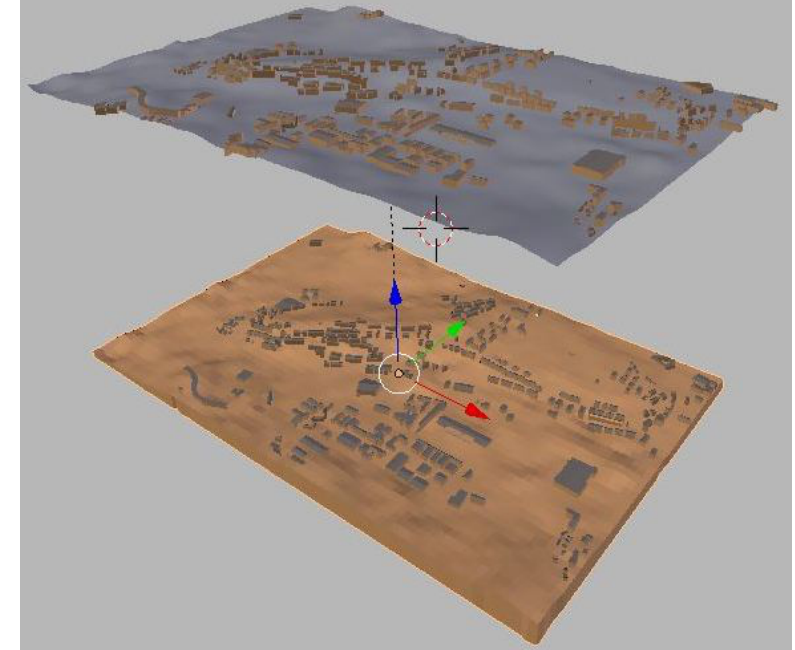
Figure 2. Terrain and buildings as Blender